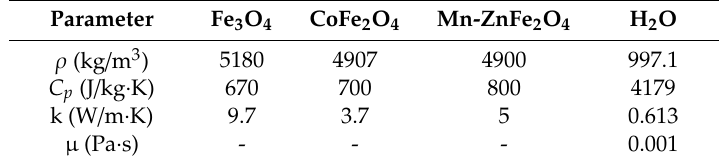
Table 1. The thermo-physical properties of water, Fe 3 O 4 , CoFe 2 O 4 , and Mn-ZnFe 2 O 4 particles.